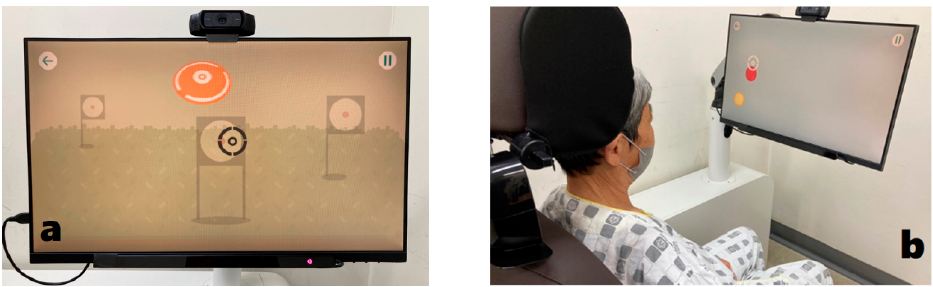
Figure 1. Eye-tracking linkage attention training system: ( a ) Eye tracker is attached under the monitor. ( b ) If the patient focuses on the target presented on the screen, the eye tracker recognizes the eye movement and solves the problem.